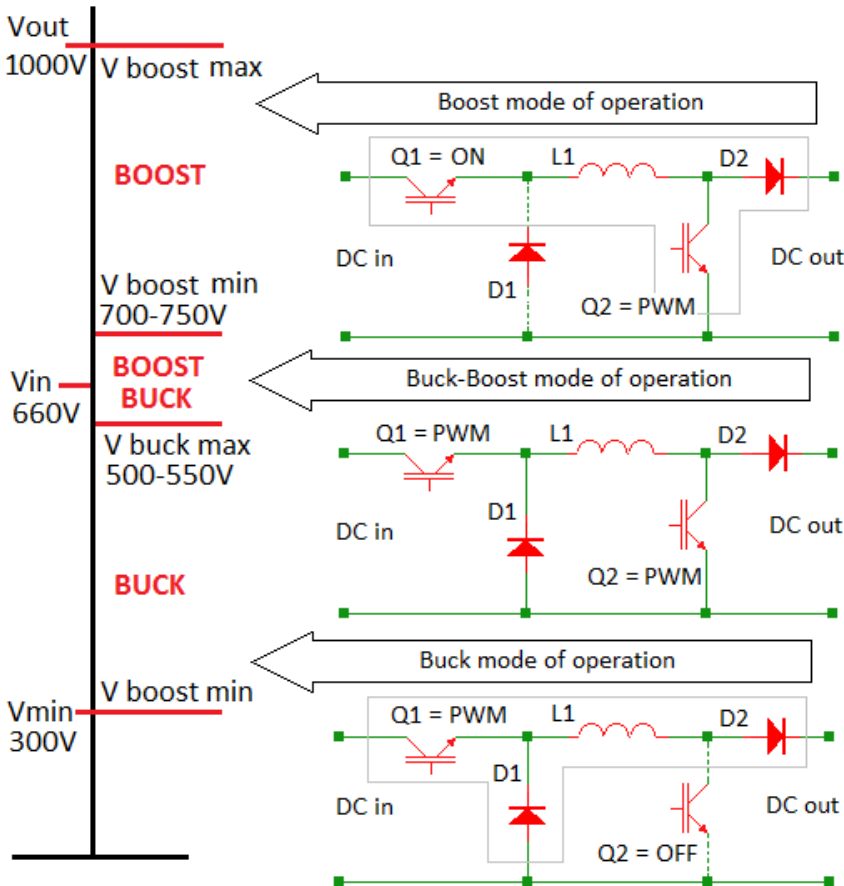
Figure 4. Buck, Boost and Buck-Boost modes of operations. Their activation and the necessary pulse width modulation (PWM) is presented according to the output voltage range.